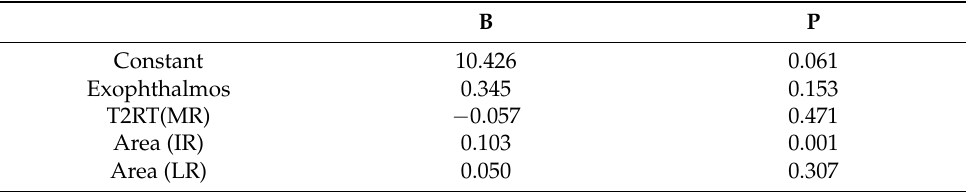
Table 4. Model of liner regression.